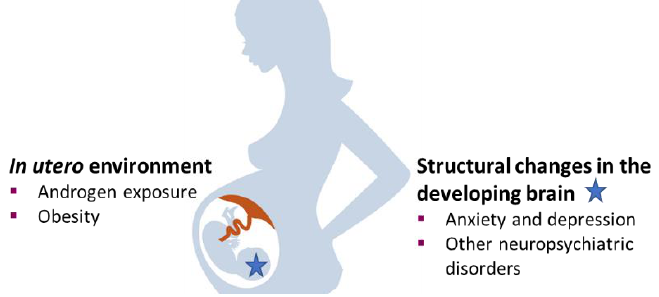
Figure 1. Hypothetical model of prenatal androgen exposure and obesity and the development of psychiatric disorder in the offspring.